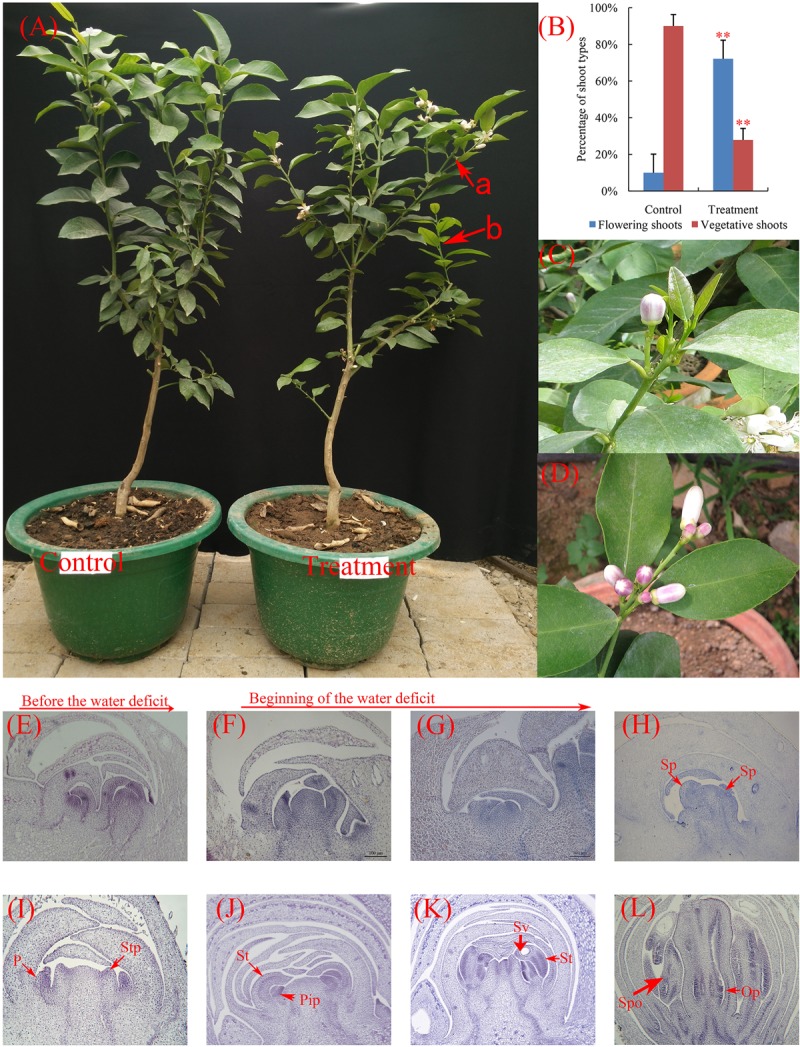
Phenotypic characteristics and cytological changes of lemon during floral inductive water deficits. (A) The control and water deficit-treated plants after resumption of irrigation. a, a statistical unit of flowering shoot; b, a statistical unit of vegetative shoot. (B) Effect of water deficit on flowering of lemon. The data were processed using one-way analysis of variance (ANOVA), and statistical differences were compared based on Student’s t-test, taking P < 0.01 as ∗∗. (C) Single flowers from the water deficit-treated plants. (D) Leafless inflorescences from the water deficit-treated plants. (E–L) The floral differentiation on lemon buds. The integrated flower bud was formed in 2 or 3 weeks, and then flower bud began flowering. (E) Undetermined state. (F) Lateral bud growth resumes. (G,H) Flower primordium forms and sepal primordia arise. Sp, sepal primordia; P, petal; (I,J) Stamen primordia arise. Stp, stamen primordia; Pip, pistil primordia; (K) Stamen and pistil primordia arise. St, stamen; Sv, secretion vesicle. (L) Fully developed floral bud. Spo, sporogenous; Op, ovule primordia. The bars represent 50 μm (E–H) and 100 μm (I–L).